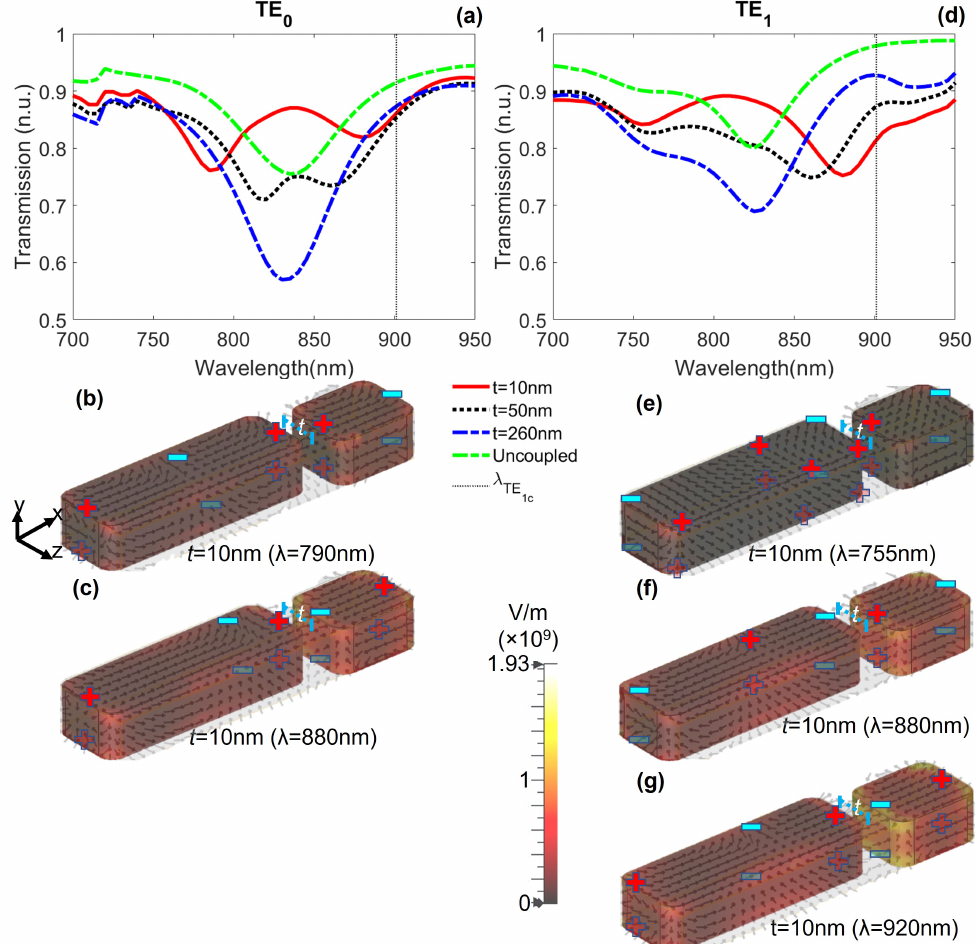
Figure 6. Transmission spectra for a dimer with the short NP longitudinally displaced by distances t = 10,50,260 nm. ( a ) For the TE 0 mode, the EIT-like effect is present around λ = 835 nm. ( b , c ) Electric field lines on the NPs for TE 0 mode. ( d ) For the TE 1 mode, the transparency effect is observed around λ = 810 nm due to strong coupling of the NPs. The larger the value of t , the weaker the transparency window, demonstrating that, in both cases, the transparency effect is possible only if the SVEA is satisfied. ( e – g ) Electric field lines on the NPs for TE 1